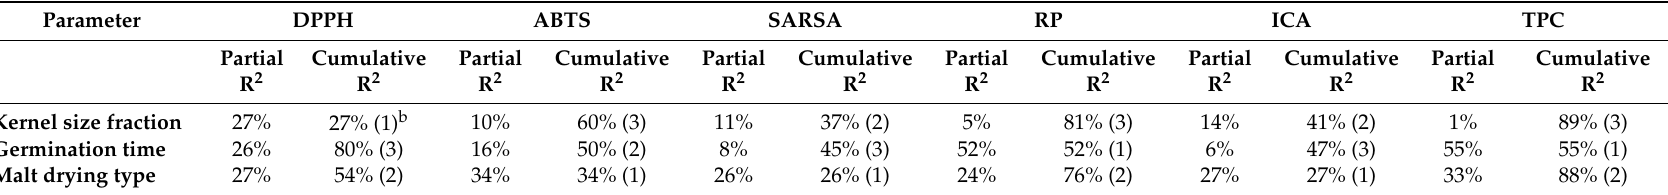
Table 4. Partial and Cumulative R 2 values from the Stepwise Regression Analysis across Experimental Parameters on Antioxidant Activities and Total Phenolic Content a